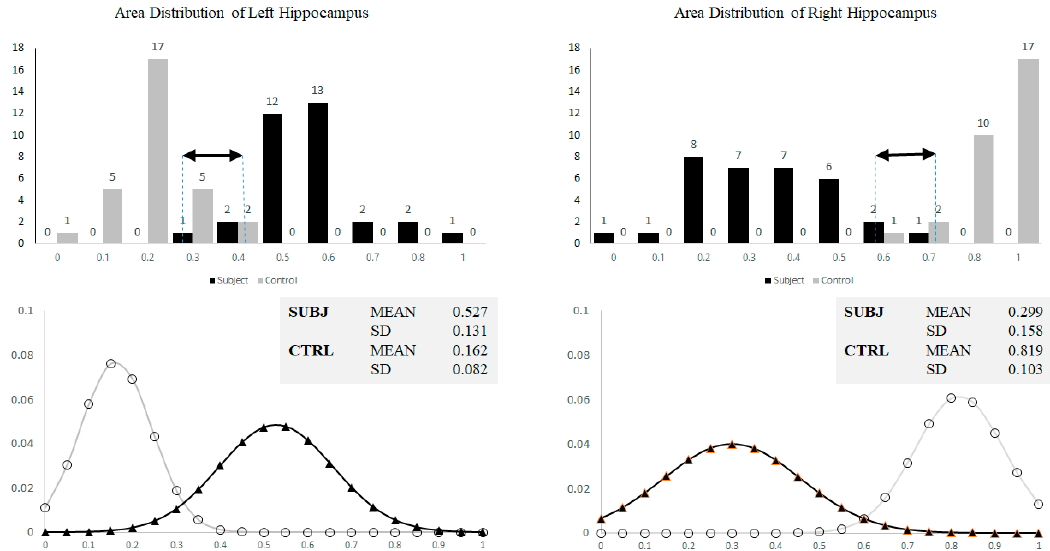
Figure 7. Histograms showing normalized area distribution ( top ) and corresponding approximated Gaussian curves ( bottom ) of left and right hippocampi for both control and subjects. Black arrows indicate overlapping area.